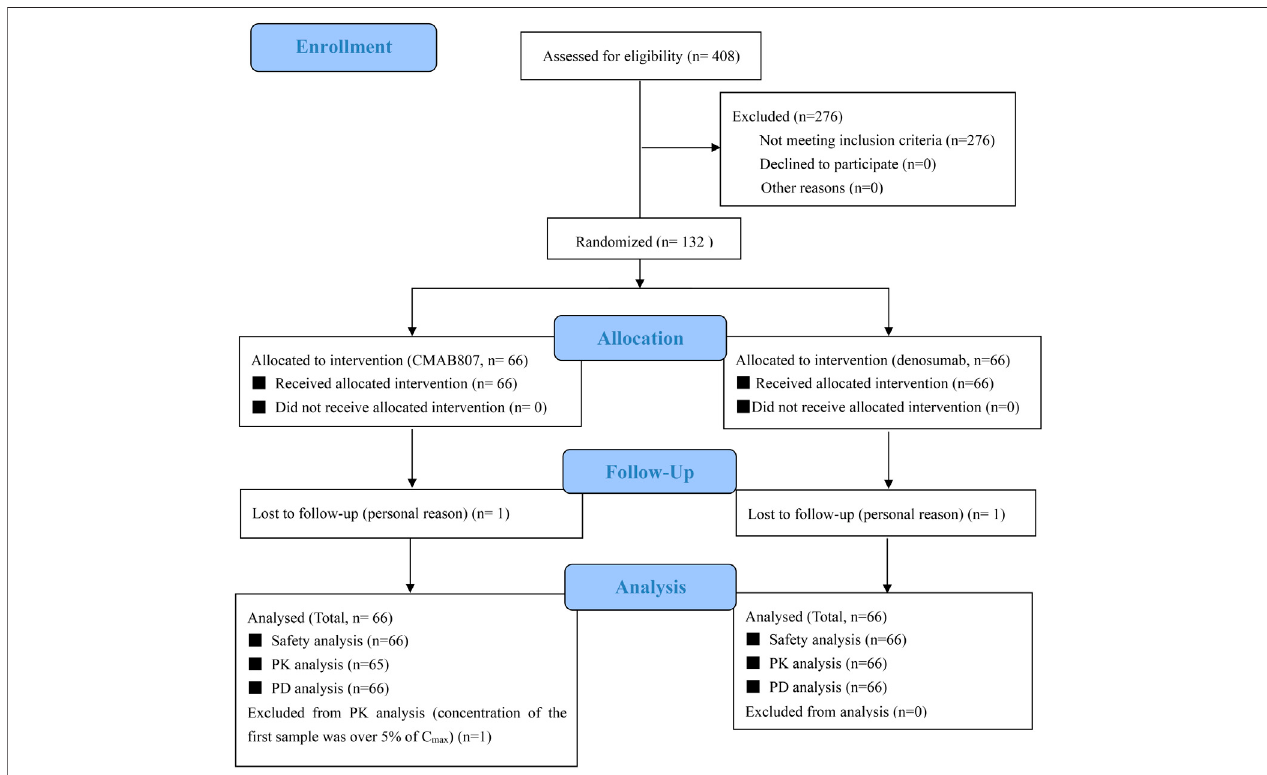
FIGURE 1 | Flow chart of the